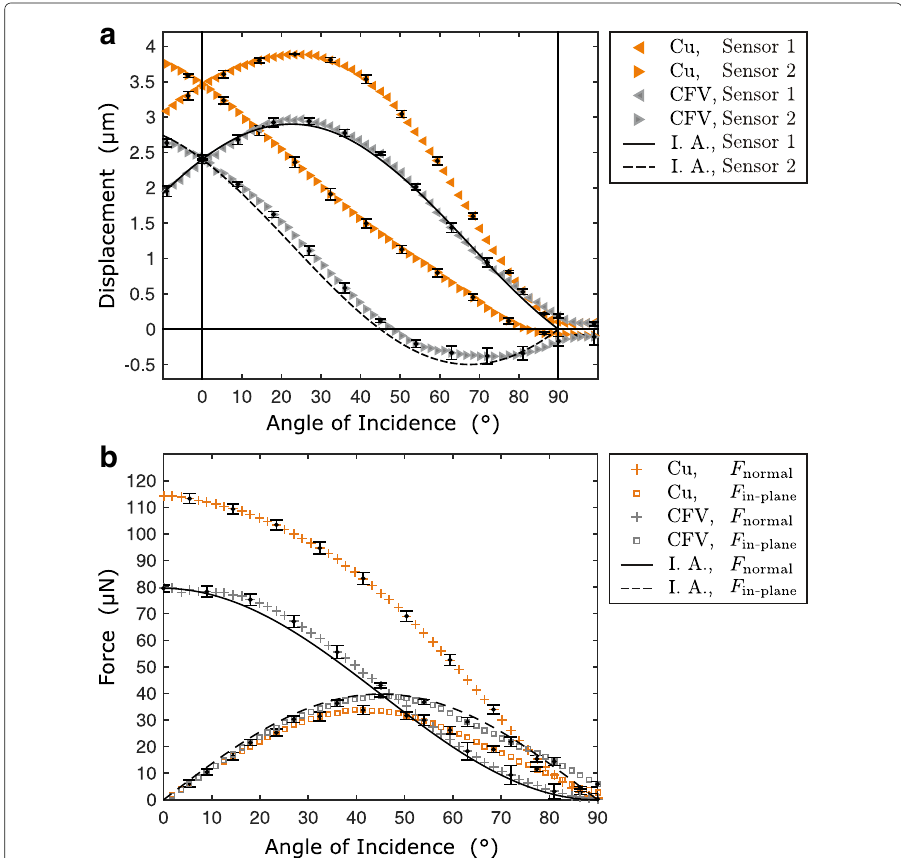
Fig. 8 Measurementsatdifferentanglesofincidence. a Diplacements measured by the two sensors, b calculated normal and in-plane force coordinates of the same data. The forces are caused by a 1.2keV Ar/Ar + beam impacting on a copper (Cu) and a carbon fiber velvet target (CFV). The calculated solid and dashed lines indicate the theoretical case of ideal absorption (I.A.) without sputtering. For the sake of legibility, only every fifth error bar is plottet